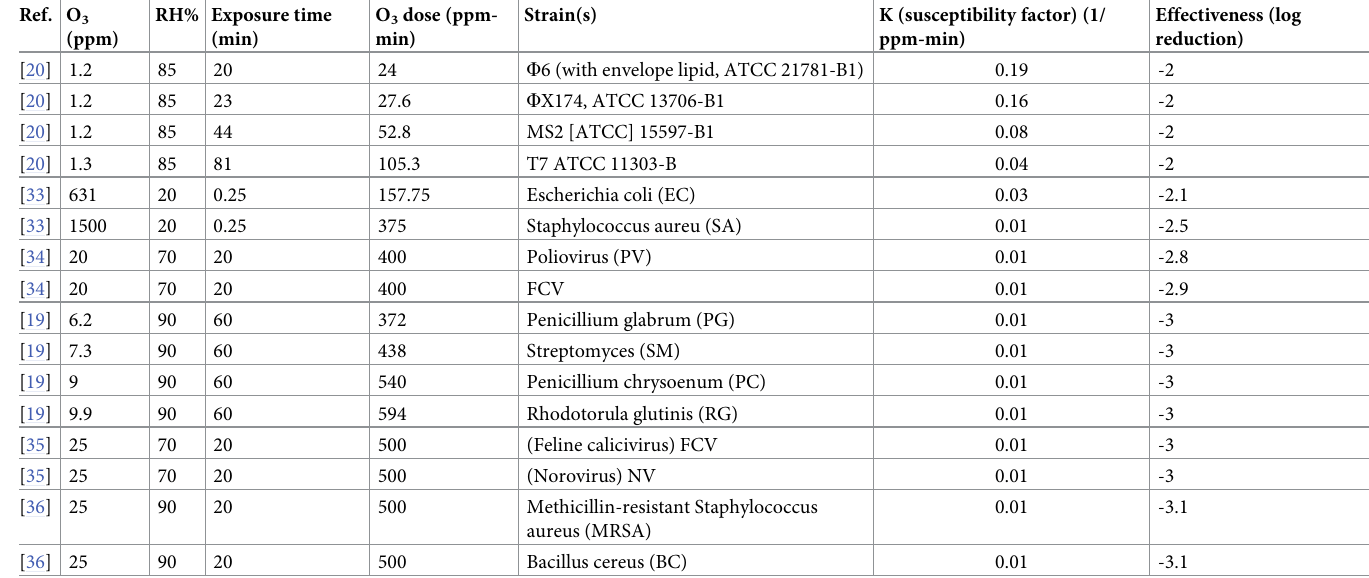
Table 1. A summary of O 3 concentrations for different strain log